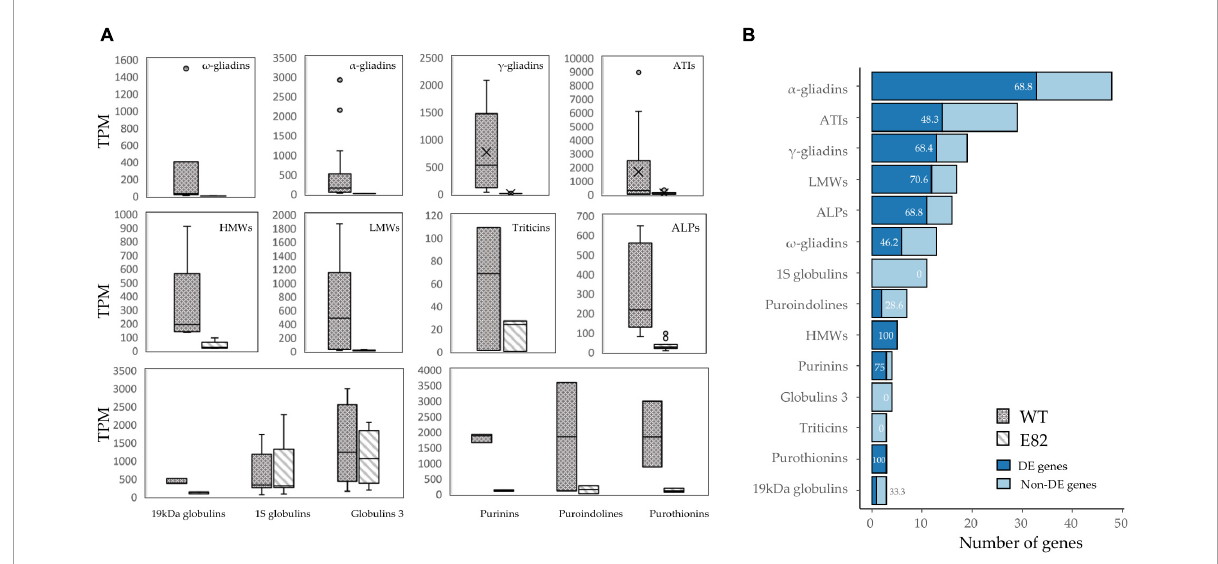
FIGURE2 (A) Overview of the expression of differentially expressed (DE) genes coding for grain proteins between the wild type (WT) and E82. For globulins and triticins, we represented all genes. The line in the box represents the median value. (B) Number of DE and non-DE genes for each protein type. The number in bars indicates the percentage of DE genes. Gene annotations were extracted from the RefSeq v1.1, Juhász et al. (2018) and Altenbach et al. (2020) and Huo et al. (2018a,b), and for triticins, we performed a blastp of three protein sequences of triticins from Butte 86 summarized in Altenbach et al. (2020) against the wheat